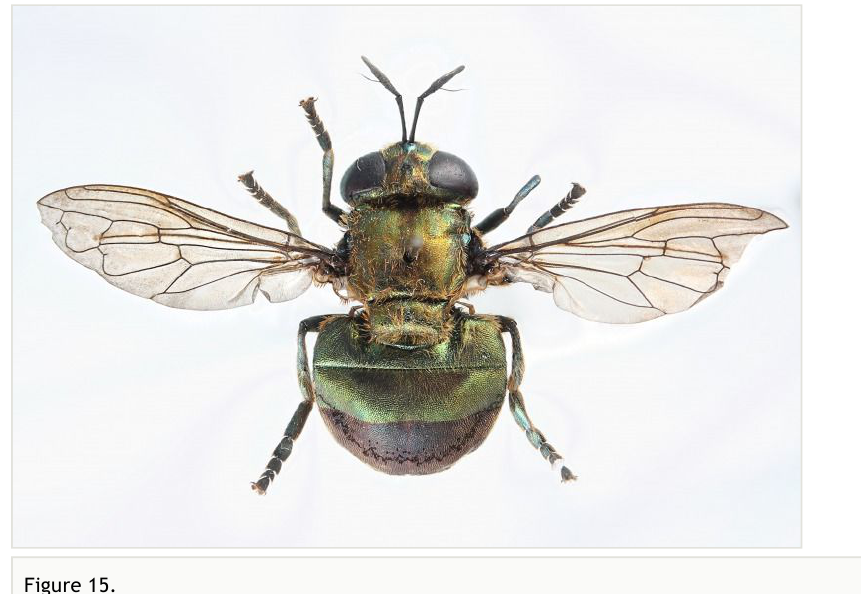
Figure 15. Dorsal view of the microdontine adult (individual No.